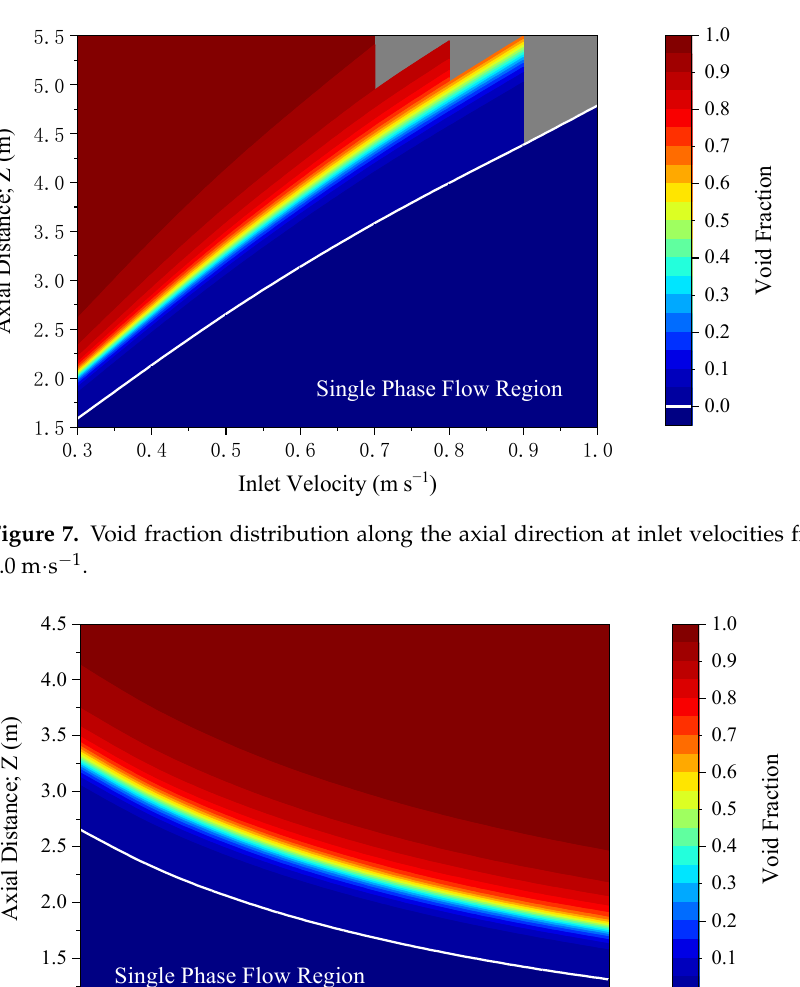
Figure 8. Void fraction distribution along the axial direction under wall emissivity from 0.40 to 0.80.